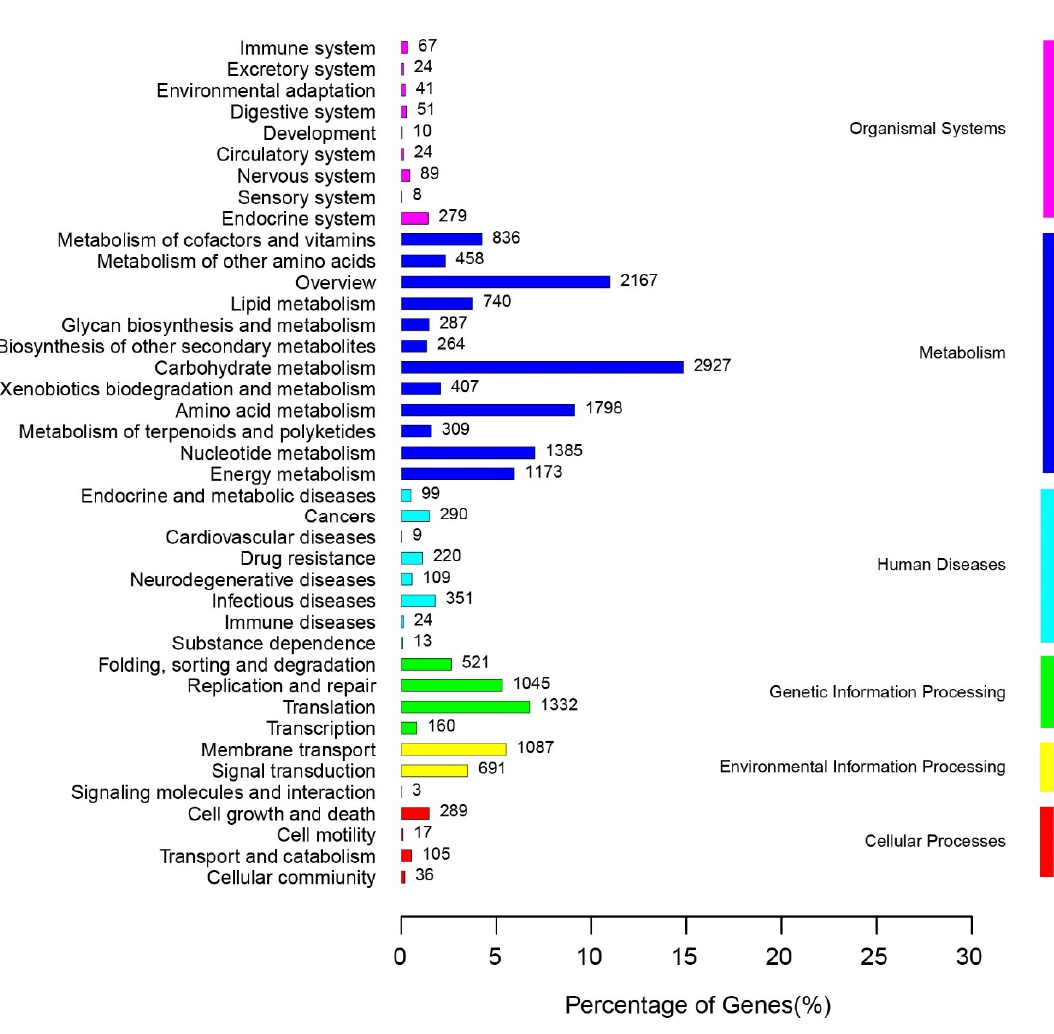
Figure 4. KEGG functional classification of functional genes in suansun microorganisms. Based on the GO database, functional annotations indicated 58 GO function catego- ries (Figure 5). The biological process included 22 branches, and the number of genes an- notated in single-organism process, cellular process, and metabolic process ranked in the top three, with 16,737 (29.12%), 16,325 (28.41%), and 15,682 (27.29%), respectively. This is consistent with the large number of metabolism-related genes annotated in the eggNOG and KEGG databases. The cellular component included 21 functional categories, and 24,714 genes (54.00%) were annotated to cell and cell parts. Catalytic activity had the high- est number of annotated genes in the molecular function. Interestingly, we also identified a number of genes associated with human diseases. As suansun is artificially salted, asso- ciated bacterial contamination may be introduced during the preparation process.